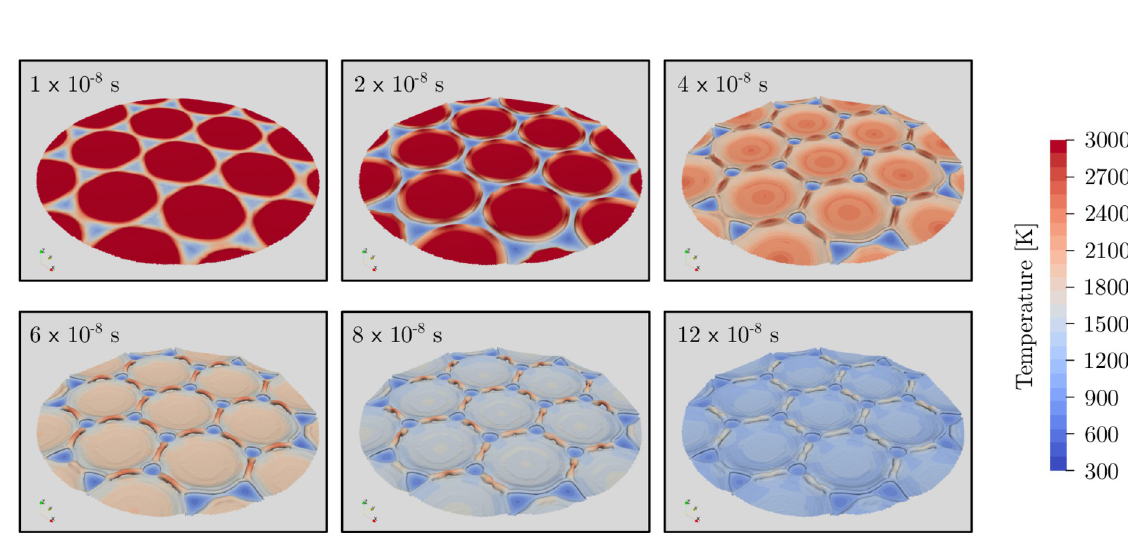
Fig 8. Simulated, three-dimensional surface structures at different time steps for the parallel polarization orientation at a laser fluence of 4.2 J/cm 2 .